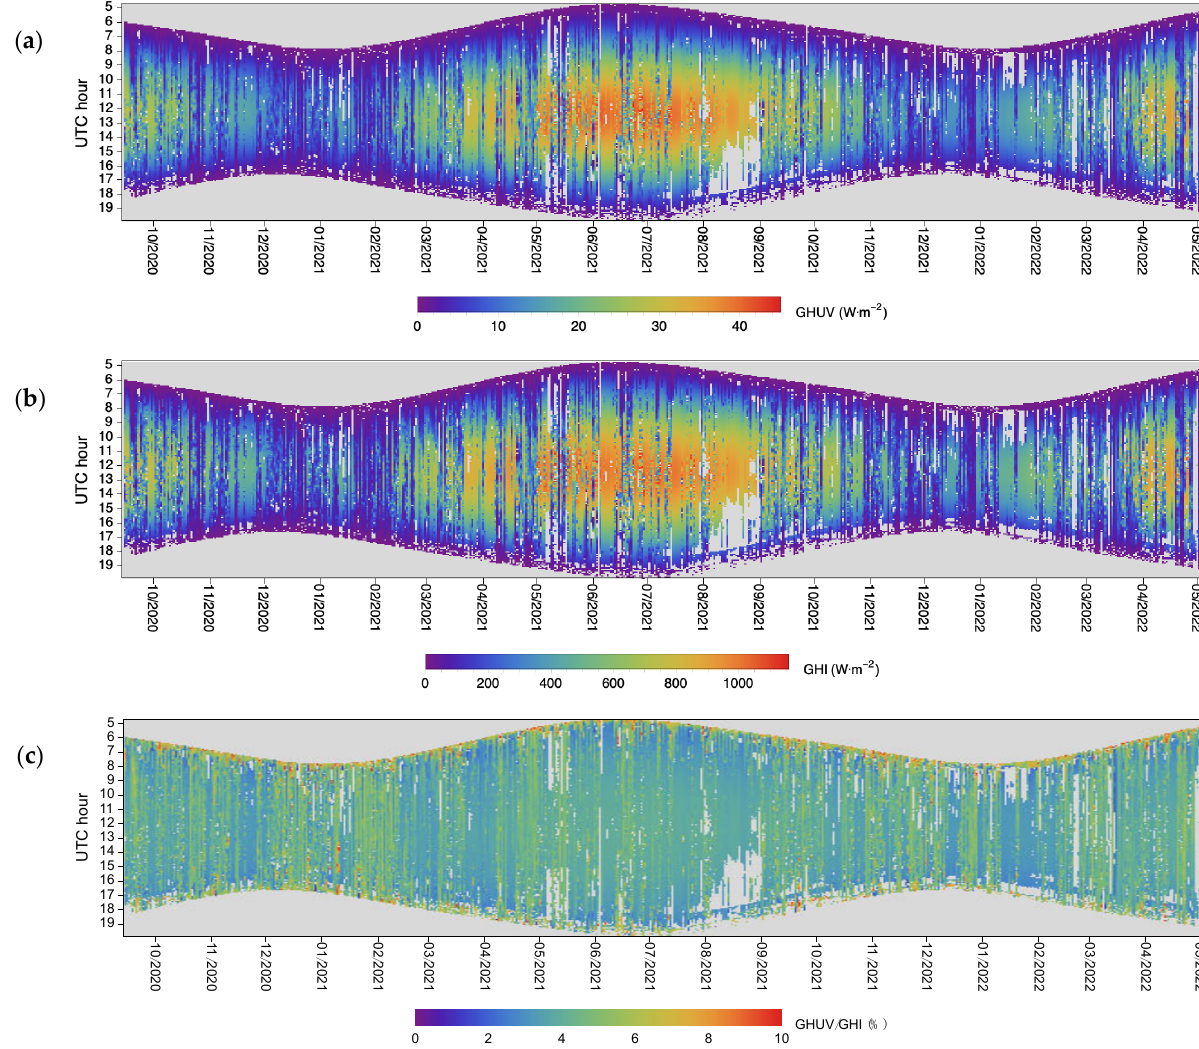
Figure 4. Ten minute experimental data of ( a ) GHUV (W · m − 2 ), ( b ) GHI (W · m − 2 ), and ( c ) the GHUV/GHI ratio (%) throughout the experimental